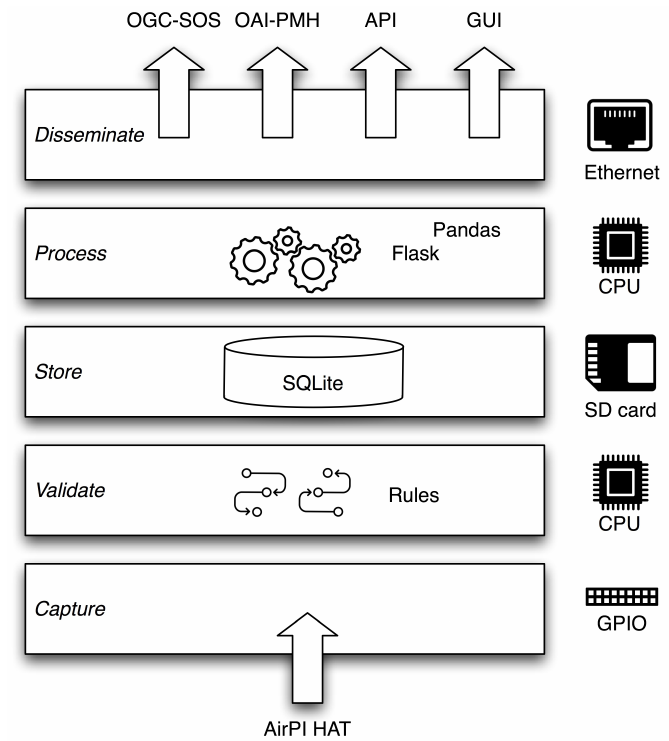
Figure 1. Airchive abstract architecture. System services are shown as layered components on the left , with relevant technologies. On the right , corresponding Raspberry Pi features are